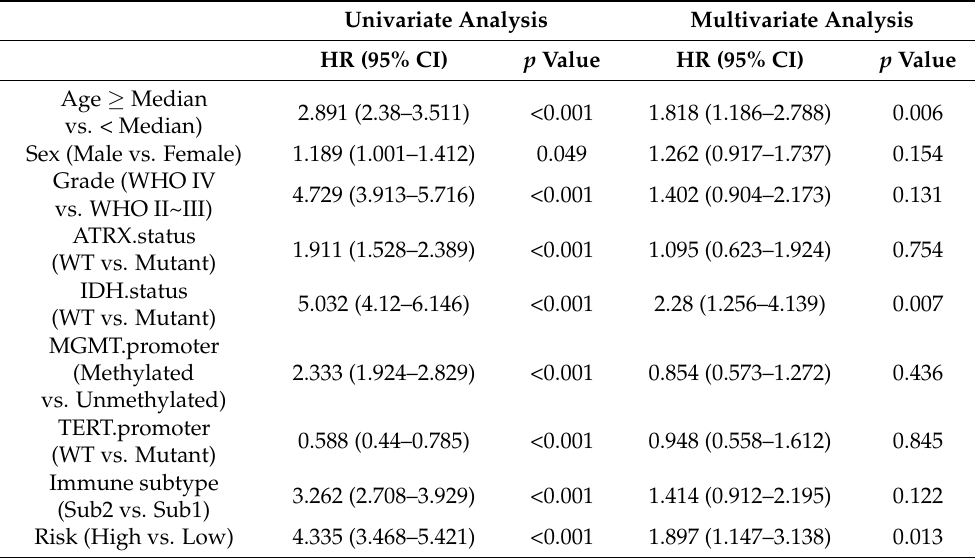
Table 1. Univariate and multivariate Cox regression analysis of clinical pathologic features in TCGA